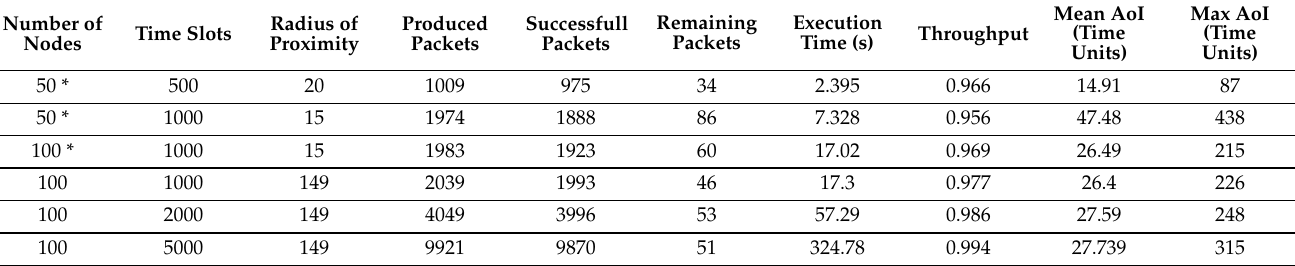
Table 5. Initial results for FRESH-neigh.